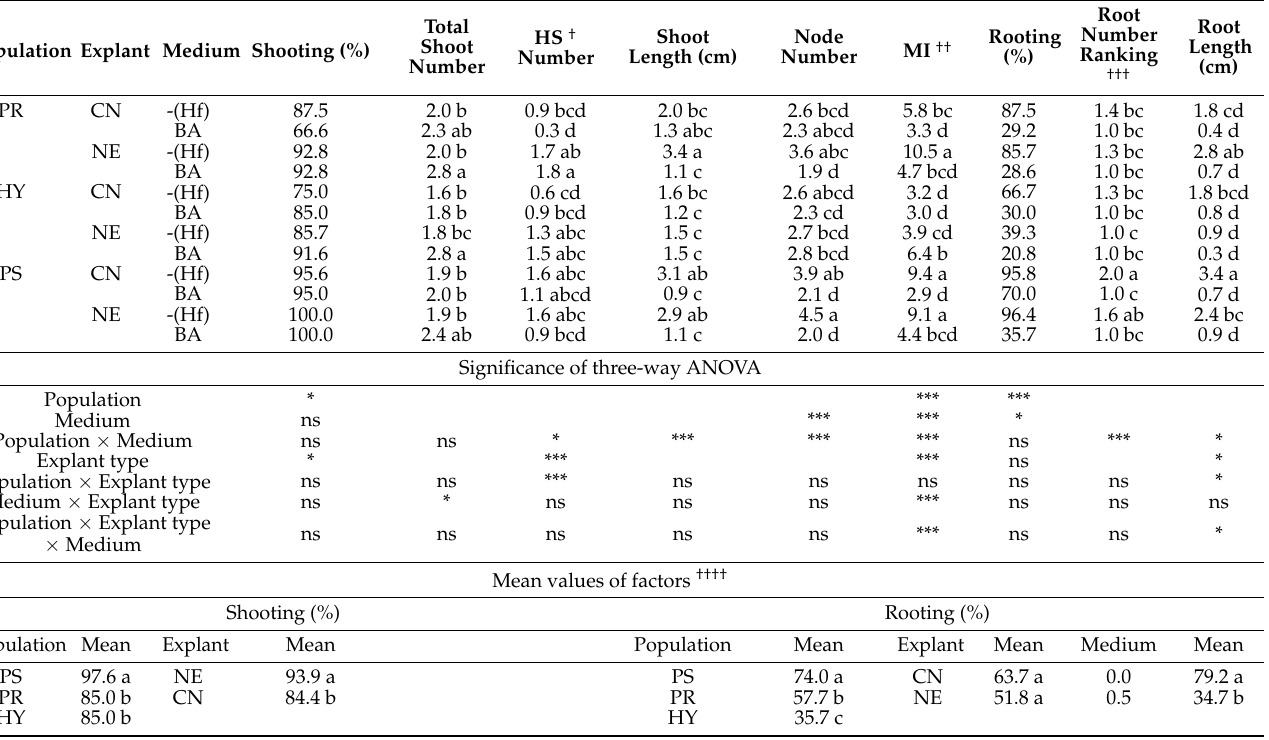
Table 1. Establishment of initial cultures of three populations (Parnitha, Hymettus, Parnassos: PR, HY and PS respectively) of C. candidissimum , by cotyledonary-node (CN) and stem-node (NE) explants, excised from in vitro grown seedlings, on Murashige and Skoog media, hormone-free (Hf) or supplemented with 6-benzyladenine (BA) at 0.5 mg L − 1